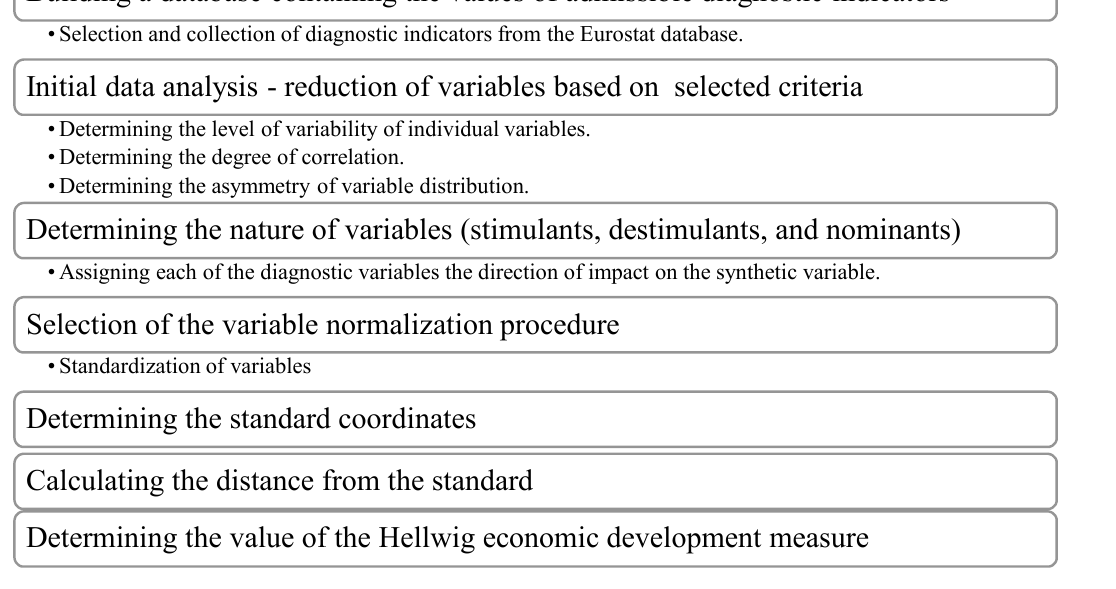
Figure 1. Procedure of determining the synthetic measure and linear ordering. Source: Authors’ own compilation based on Hellwig (1968) and Bąk (2013).